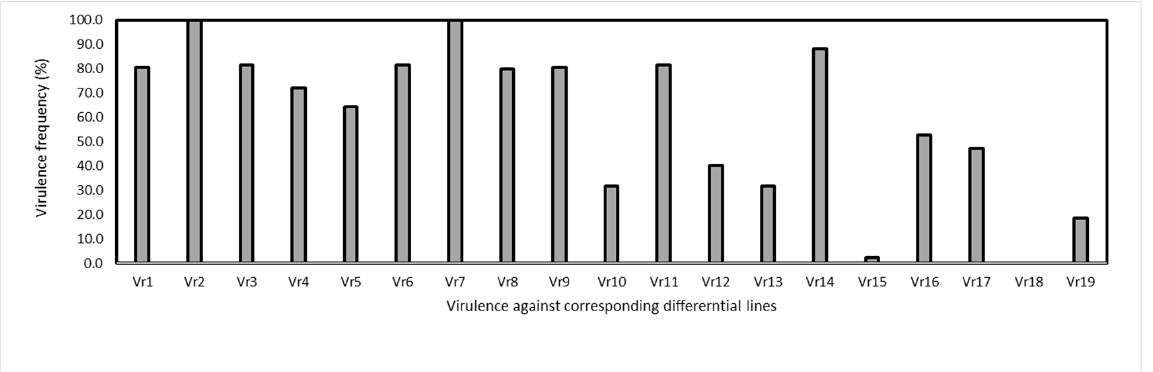
Figure 1. Frequencies of virulence factors detected in the Puccinia striiformis f. sp. tritici isolates collected from winter wheat in Yili, Xinjiang, China in 2021.